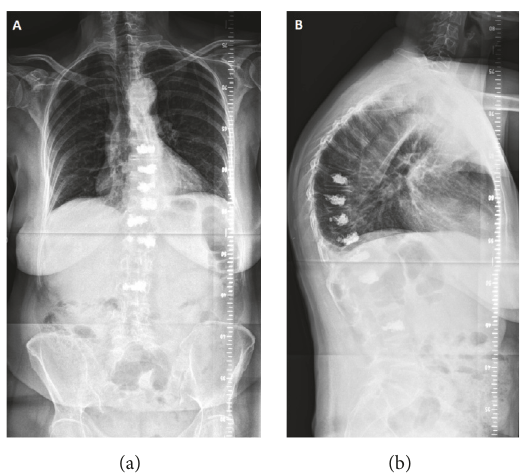
Figure 2: Postoperative anteroposterior (a) and lateral (b) radiographs of the spine.